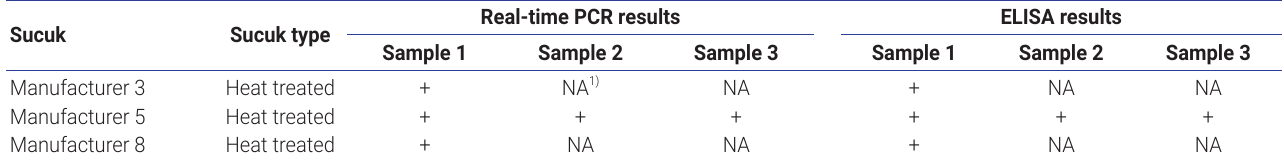
Table 2. Real-time PCR and ELISA results of 5 controversial sucuk samples analyzed for the second time Sucuk